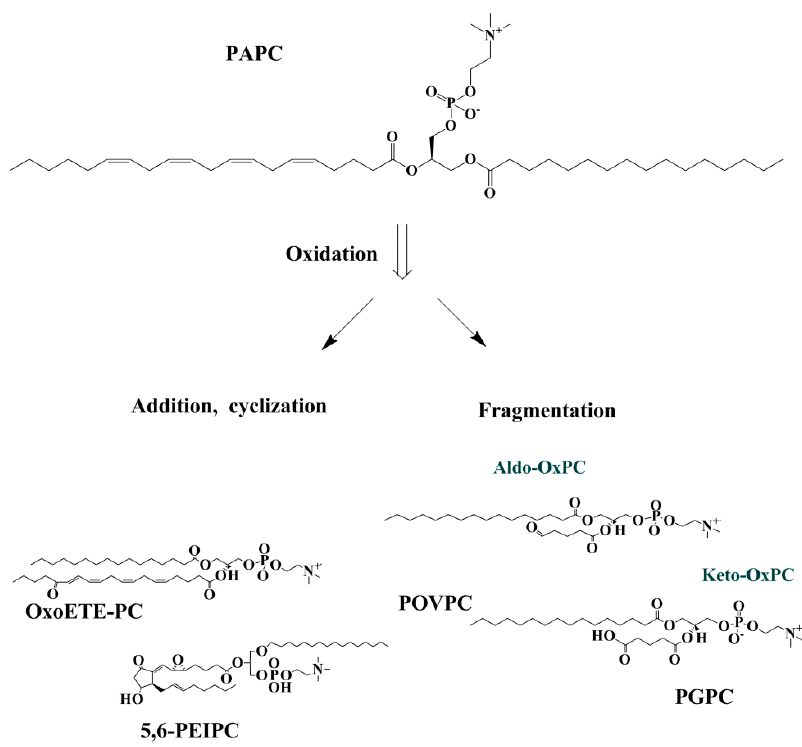
Figure 2. Fragmented and non-fragmented OxPC productions from PAPC. OxPLs can be classified as fragmented and non-fragmented species. Non- fragmented species are produced from the addition of peroxyl radicals where rearrangement/cyclization may happen. Fragmented species are comprised of aldehyde and carboxylic acid containing lipids. Abbreviations: Oxo-ETE-PC, oxoeicosatetraenoic acid phosphocholine; PEIPC, 1-palmitoyl-2-(5,6-epoxyisoprostane E2)-sn-glycero-3-phosphocholine; Aldo-OxPC, aldehyde containing oxidized phosphatidylcholine; Keto OxPC; carboxylic acid containing oxidized phosphatidylcholine; POVPC, 1-palmitoyl-2-(5 ′ -oxo-valeroyl)-sn-glycero-3-phosphocholine; PGPC, 1-palmitoyl-2-glutaryl-sn-glycero-3-phosphocholine.